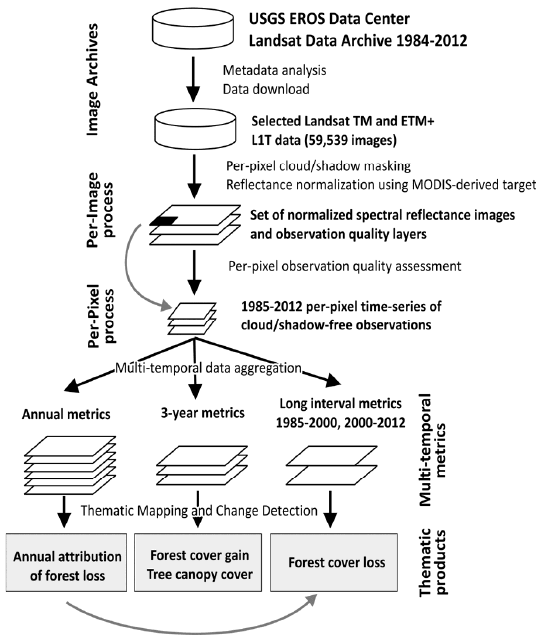
Figure 1. Algorithm for Landsat archive data processing